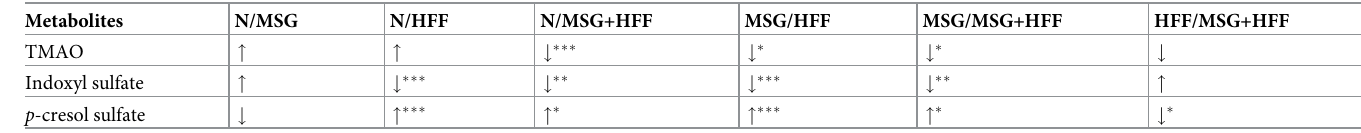
Arrows represent any metabolic changes, associated with specific diets in hamster urine in pairwise comparisons among experimental groups. Significant differences are indicated by � , �� , and ��� which correspond to p < 0.05, < 0.01, and < 0.001, respectively. TMAO; trimethylamine N -oxide, N; Normal; MSG, monosodium glutamate- treated group; HFF, high-fat and high-fructose diet-treated; MSG+HFF, group receiving a diet containing both MSG and HFF.